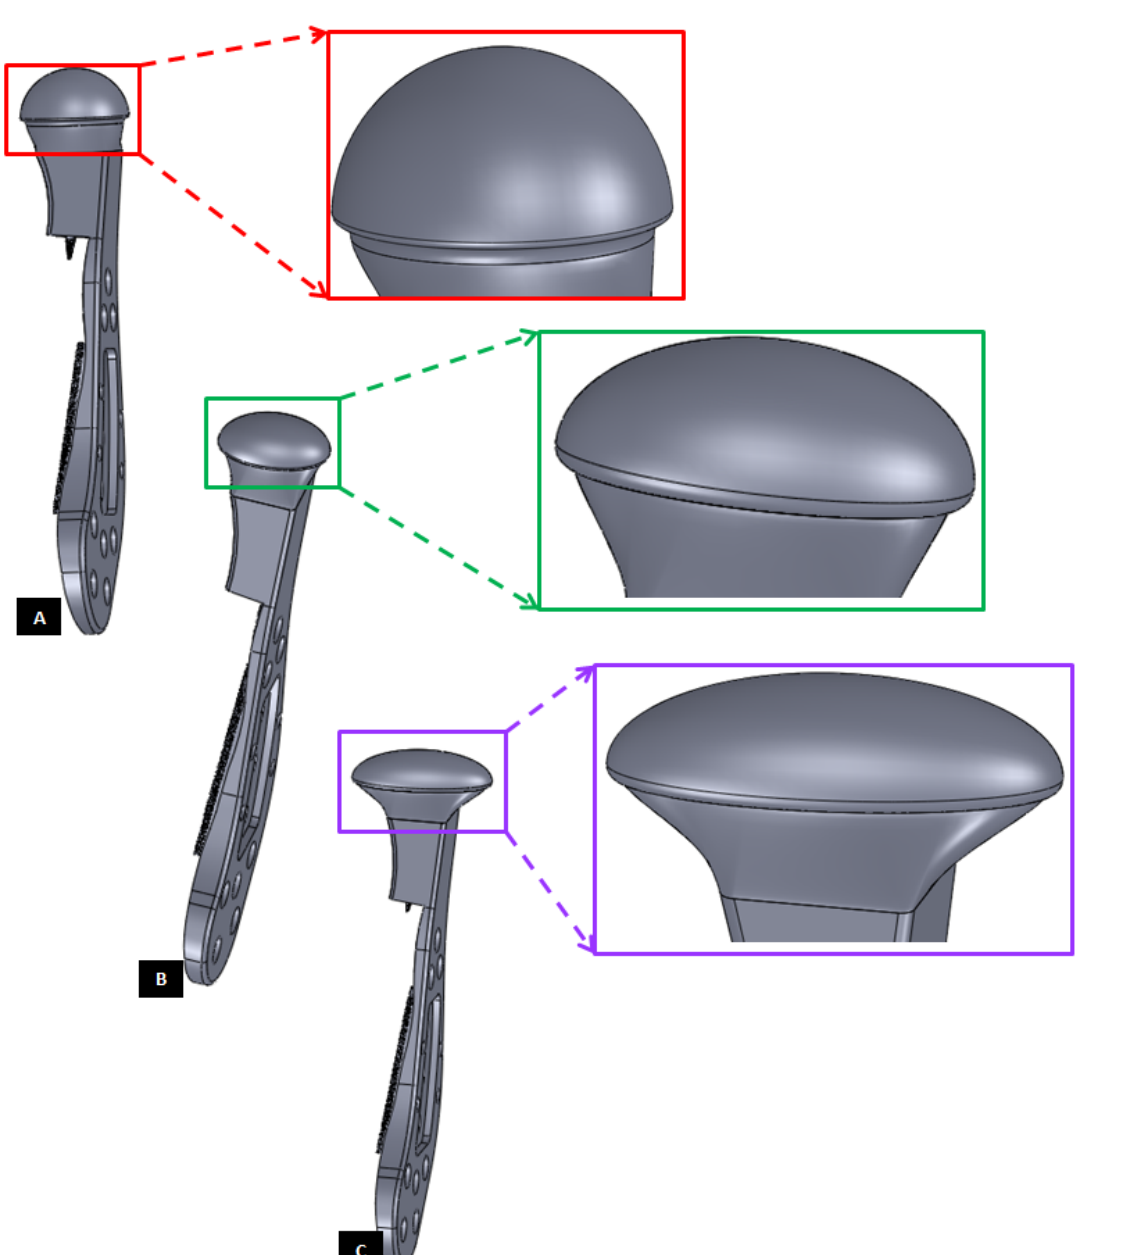
Figure 10. Different shapes of the condylar head of the custom-designed condylar/ramus component of the TMJ prosthesis. ( A ) Shows a prosthesis with spherical condylar head. ( B , C ) Show prostheses with elliptical head of different dimensions. The condylar heads are designed to offer larger articulating surface area to avoid stress concentration at small area which may lead to more wear of the articulating surfaces of reconstructed TMJ.